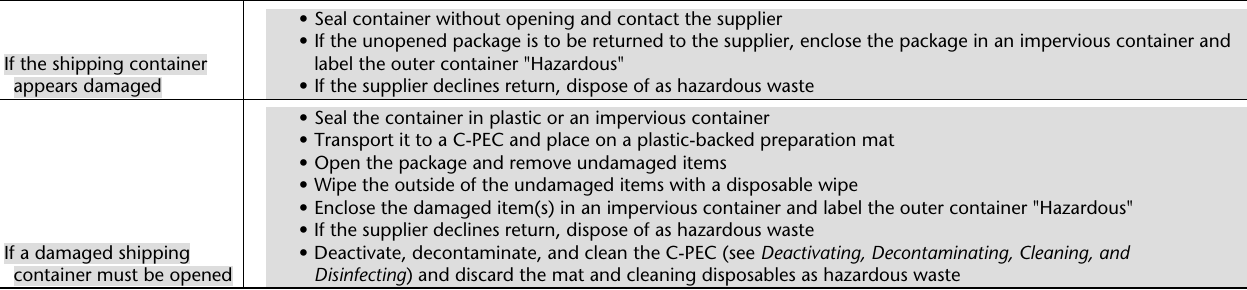
Table 4. Summary of Requirements for Receiving and Handling Damaged HD Shipping